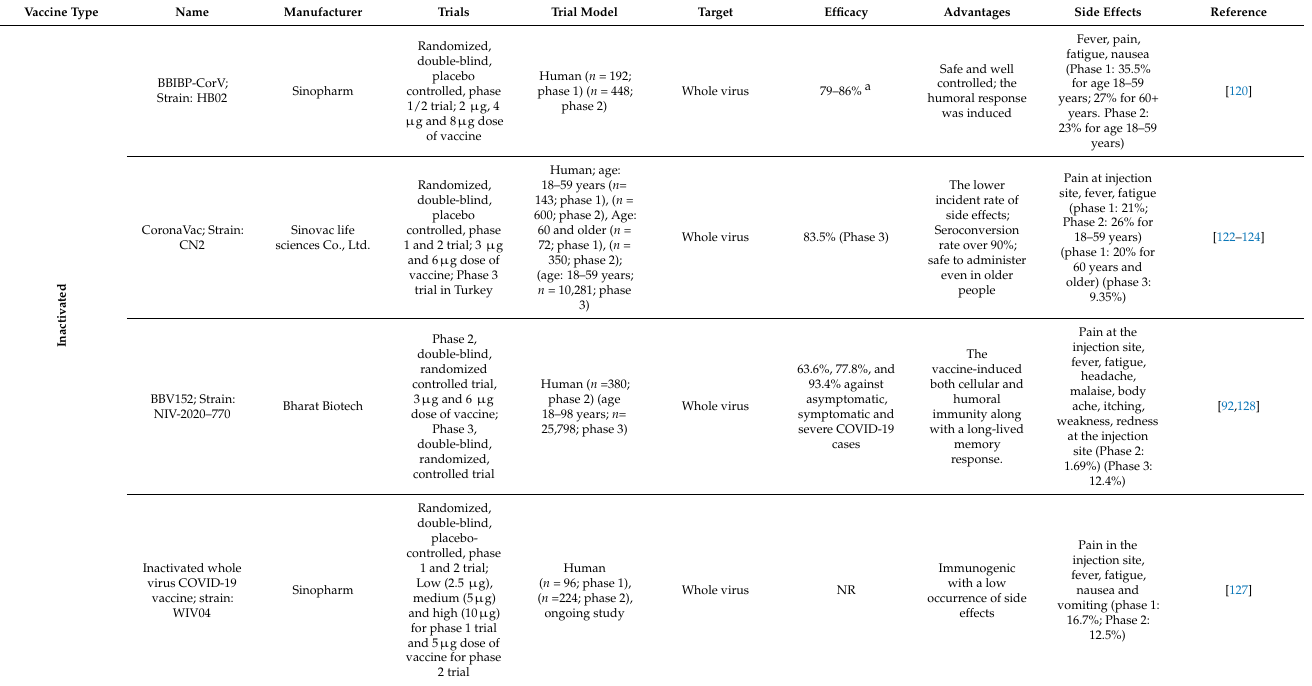
Table 2. The major characteristics of the reported COVID-19 vaccines in the trial